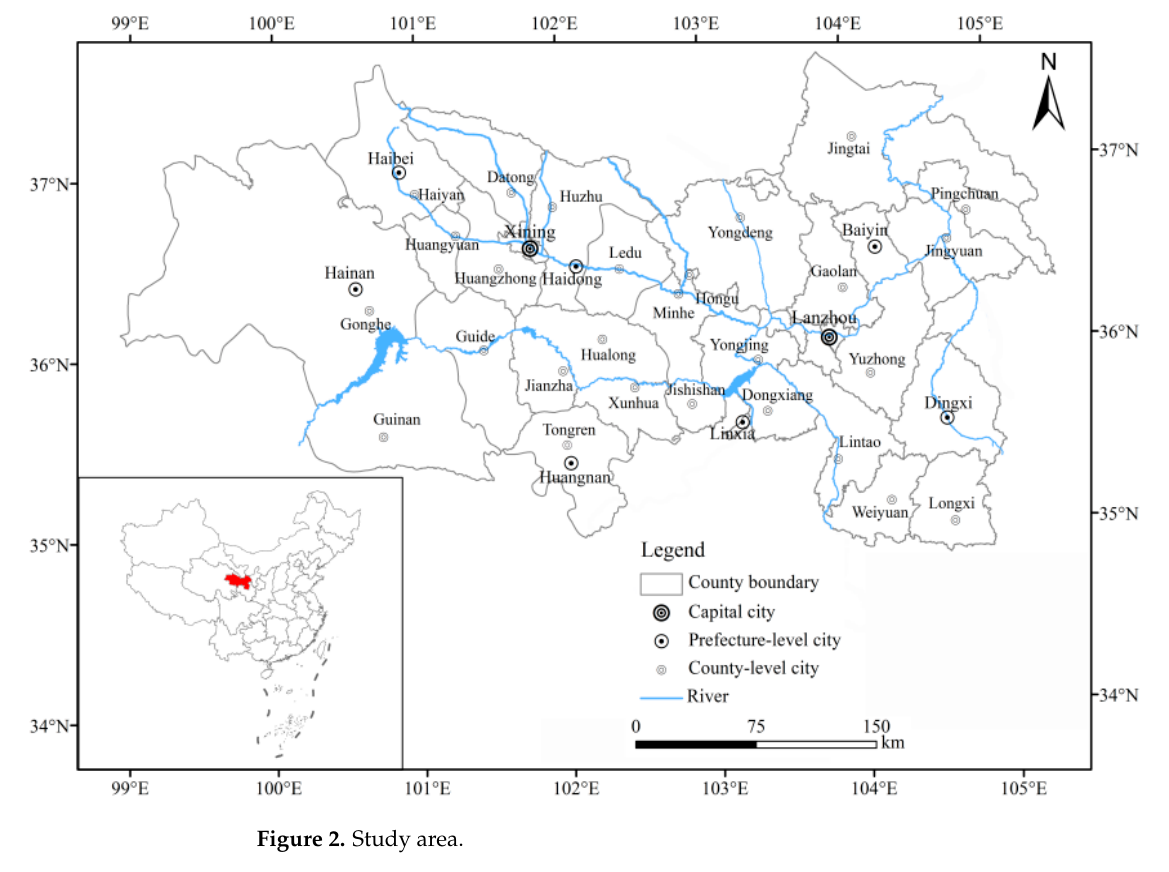
Figure 2. Study area.